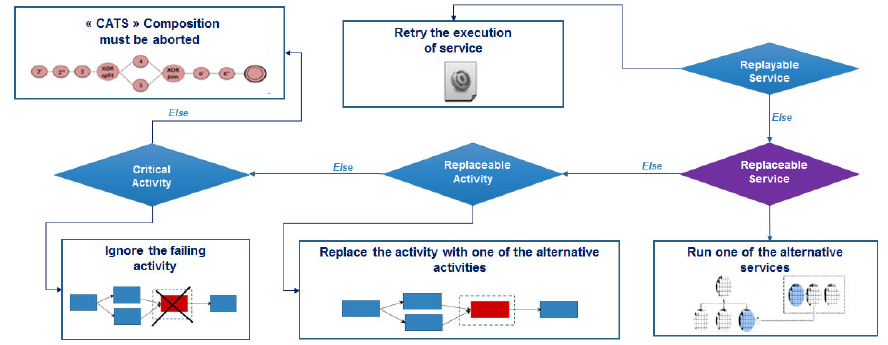
Fig. 6. CATS composition behavior according to activity